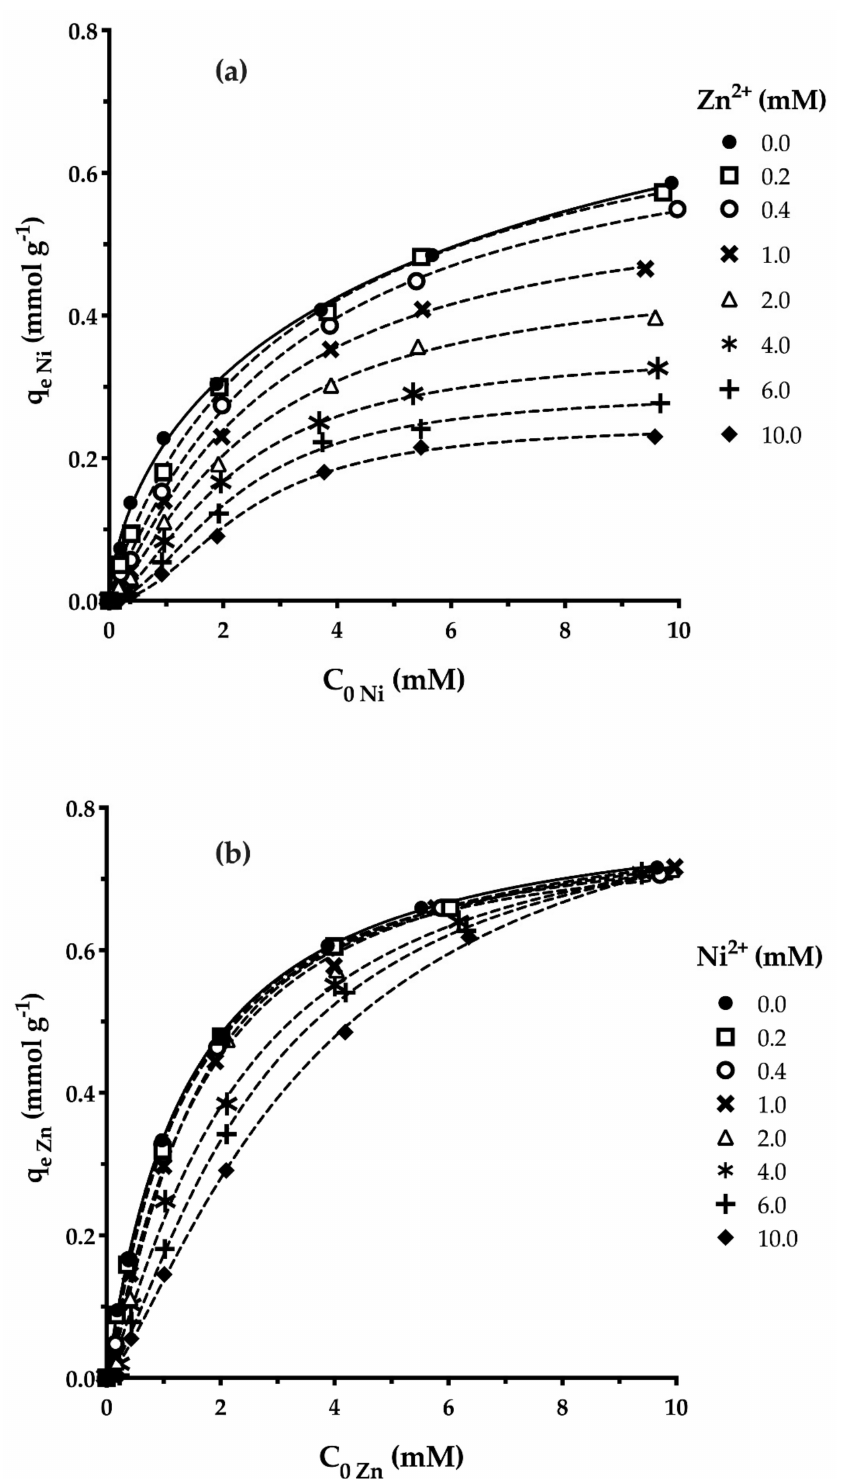
Figure 3. The e ff ects of initial metal concentration on Ni 2 + ( a ) and Zn 2 + ( b ) biosorption from aqueous solutions in binary metal